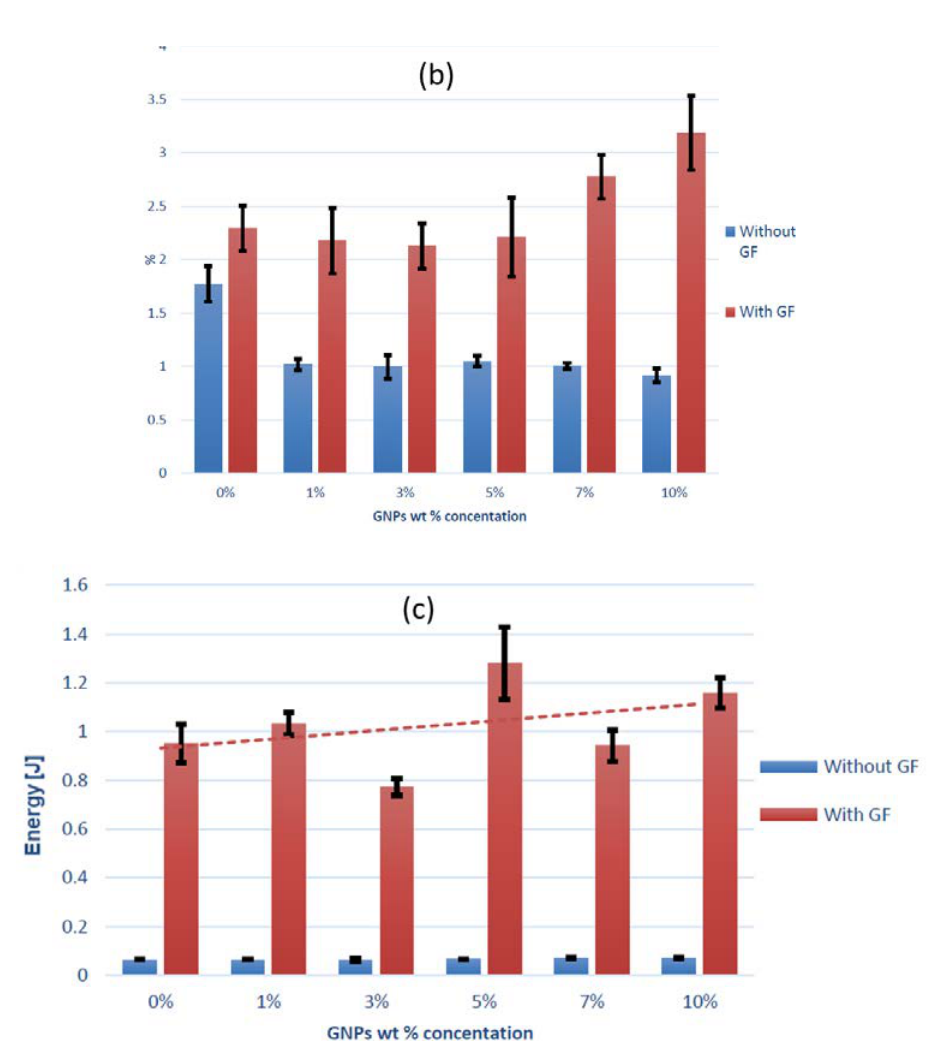
Figure 4. Mechanical properties of unfilled and GF-reinforced polyester as a function of graphene content. ( a ) Flexural stress-at-break; ( b ) flexural strain-at-break; ( c ) absorbed impact energy.